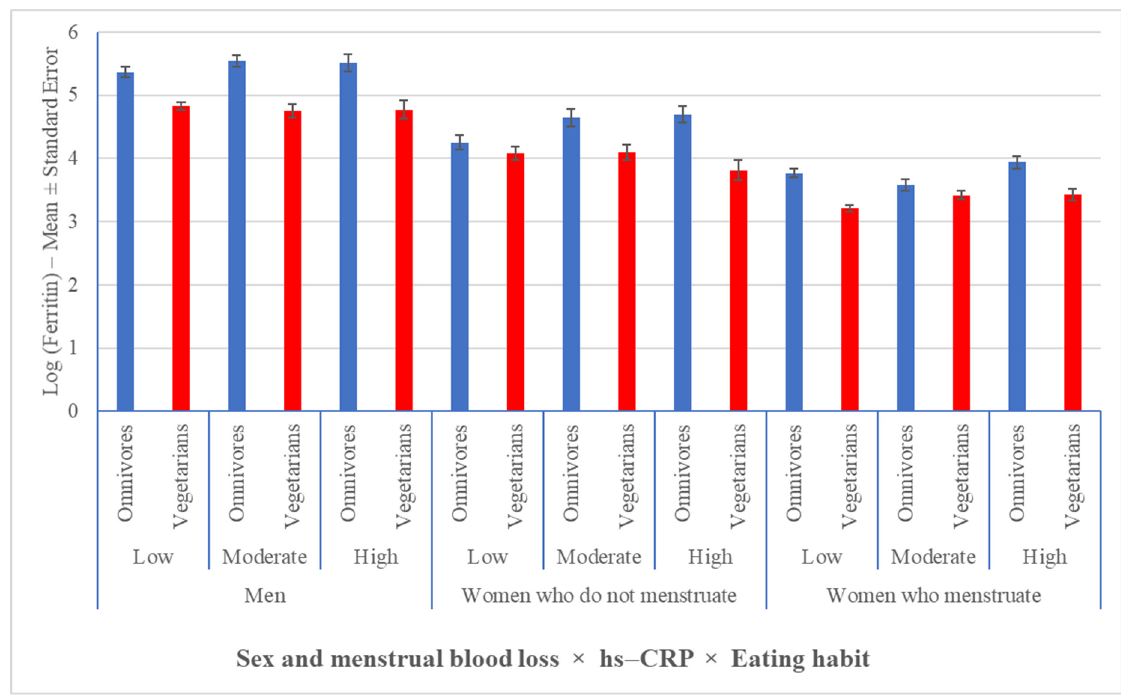
Figure 2. Variation in serum ferritin levels in vegetarian and omnivorous individuals based on degrees of inflammation, sex, and menstrual blood loss. Data expressed on the logarithmic scale.